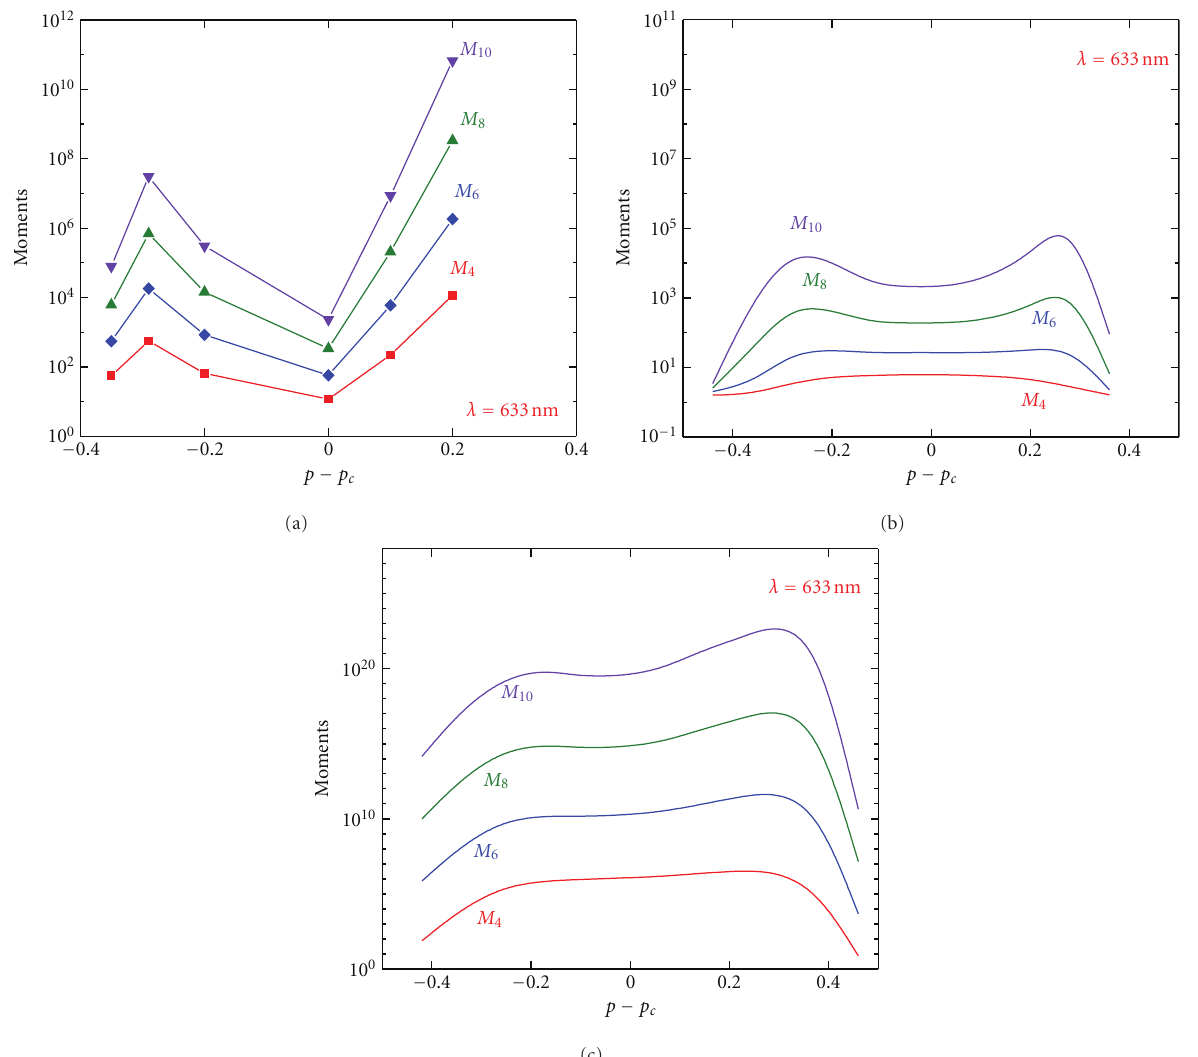
Figure 3: High-order moments of near-field intensity enhancement M 2 n as a function of silver concentration Δ p = p − p c , obtained experimentally (a) and numerically with (b) and without (c) spatial averaging [22, Figure 2]. the direction of illumination are small compared to the incident wavelength λ = 2 πc/ω , the impinging electric field